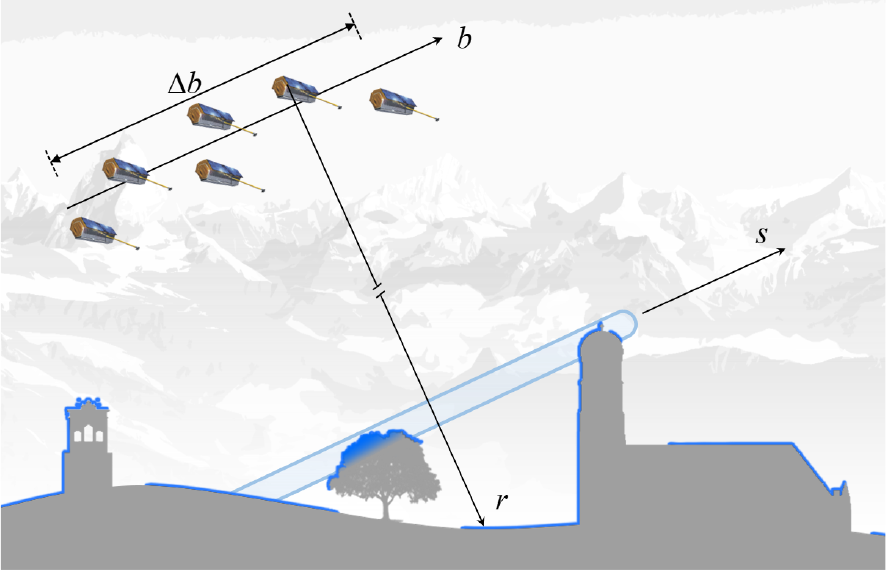
Figure 2. Schematic drawing of the principle of multi-baseline InSAR at a fixed azimuth position (modified after [8]). The TerraSAR-X satellite flies away from the reader into the screen/paper. The line-of-sight, i.e., the range direction, of the sensor is indicated by r . The range timing is always delayed after propagation through the atmosphere. The term s is the elevation direction that is perpendicular to the range. The blue outline on the surface indicates the area illuminated by radar pulses. The elongated ellipse is the range-elevation resolution cell with in which all the objects are imaged into a single pixel in the final SAR image. It is very common that several objects, such as a building roof, tree and ground, are layovered in a single pixel in a TerraSAR-X